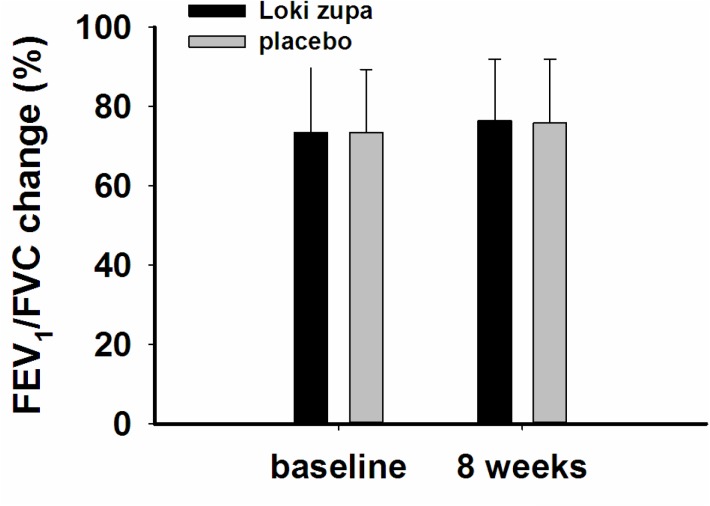
FEV1/FVC change from baseline (p = 0.805).